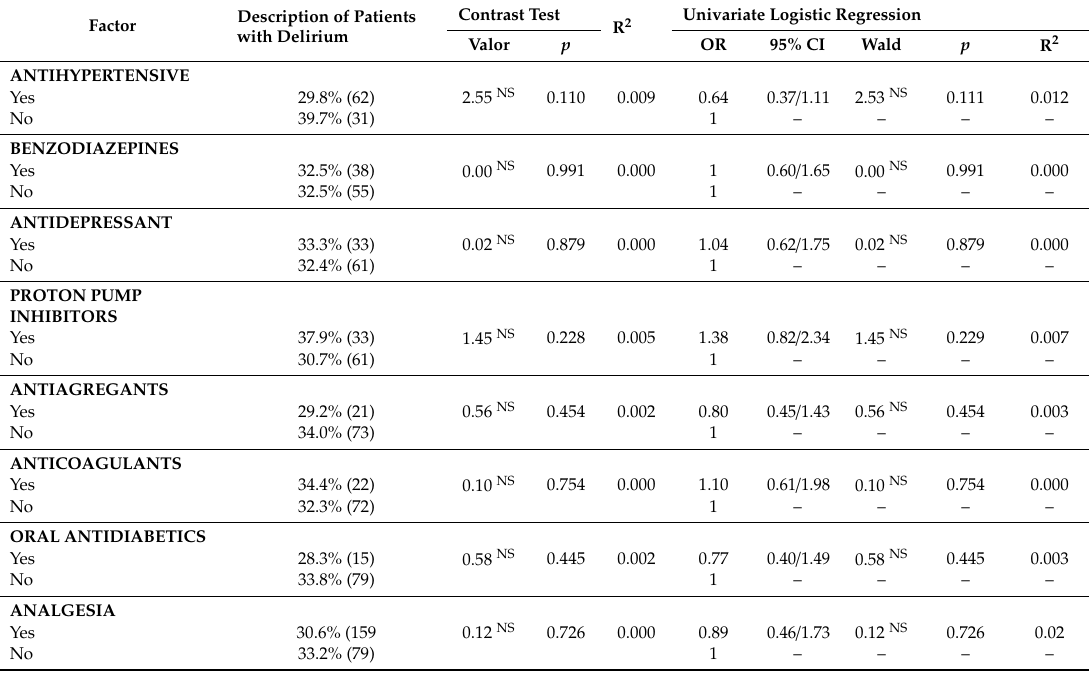
Table 5. Test of independence and univariate logistic regression. E ff ect of the type of drug administered as a factor associated with an increased risk of octogenarian women with a hip fracture developing delirium. Contrast Test Univariate Logistic Regression Factor Description of Patients R 2 with Delirium Valor p OR 95% CI ANTIHYPERTENSIVE Yes